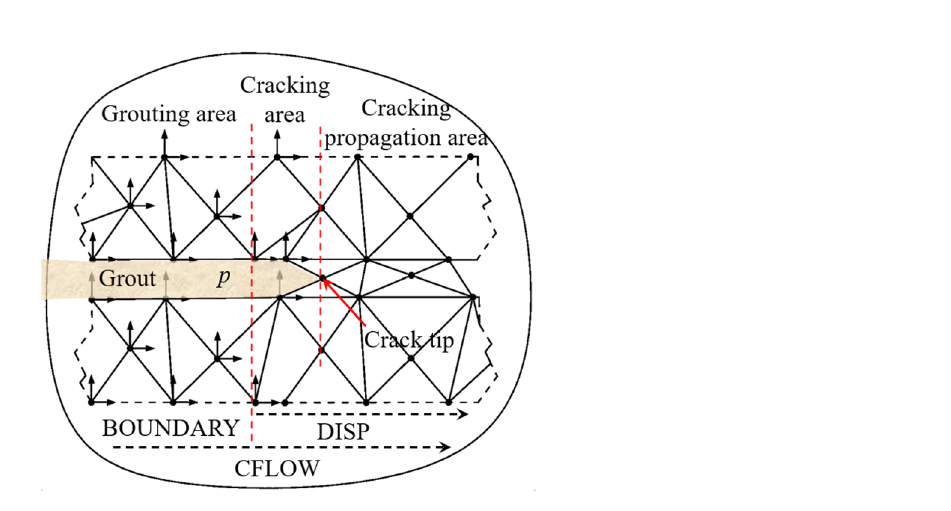
Figure 8. The geometry of 1/4-elliptical crack.